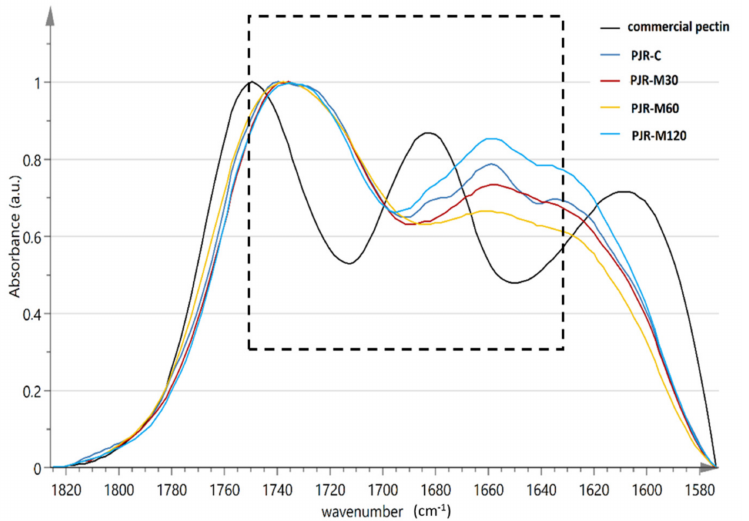
Figure 5. Smoothed, baseline-corrected FT-MIR spectra of pectin isolated from persimmon juice residues obtained from juice production process without (PJR-C) and with pulp treatment at different microwave heating conditions (PJR-M30, PJR-M60, and PJR-M120). The spectrum of commercial low-methoxy pectin from citrus is also